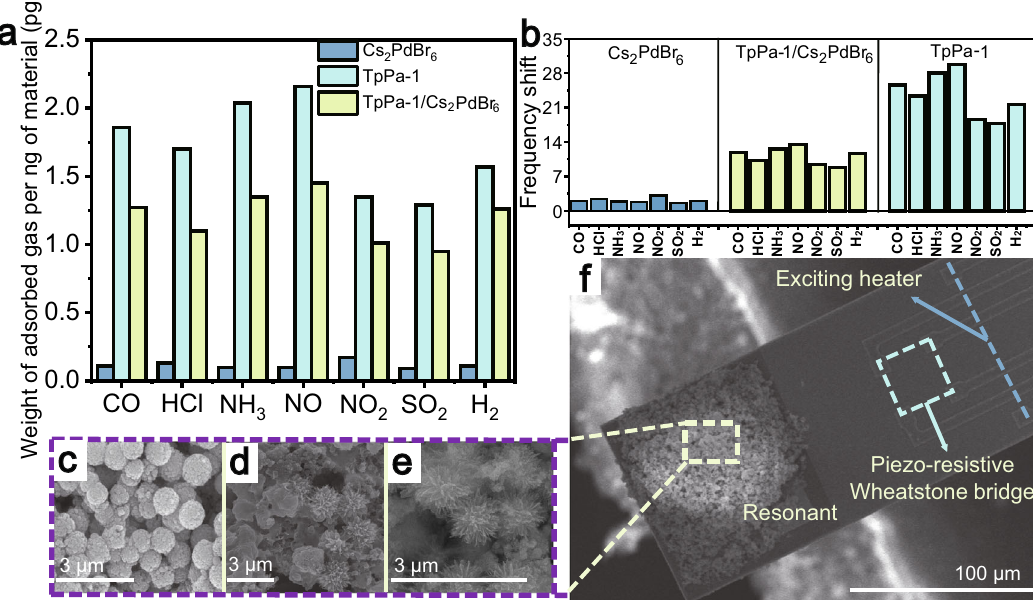
Fig. 4 | Structure and test performance of the resonant microcantilever. a The mass of gas adsorbed by 1ng of material deposited on the microcantilever. b Frequency shift of the microcantilever Cs 2 PdBr 6 , TpPa-1/Cs 2 PdBr 6 , and TpPa-1 sensors to various types of gases (all at concentrations of 2ppm). FSEM images of